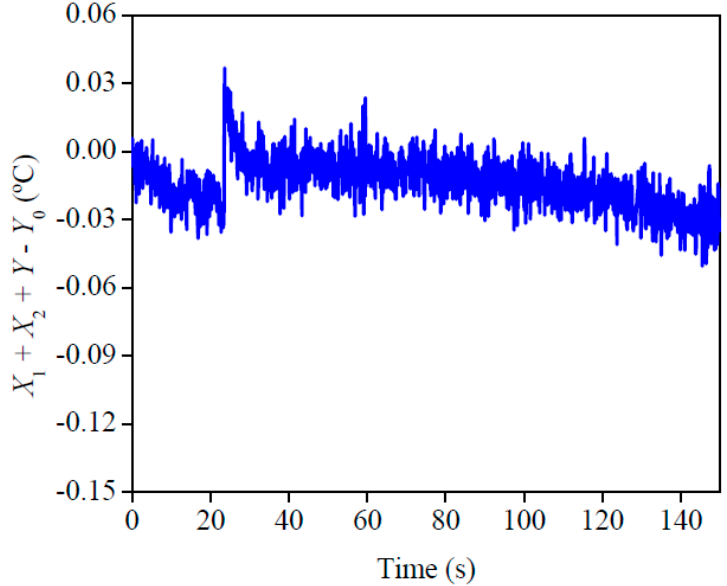
Figure 11. Values of the objective function for the AISI 304 sample.